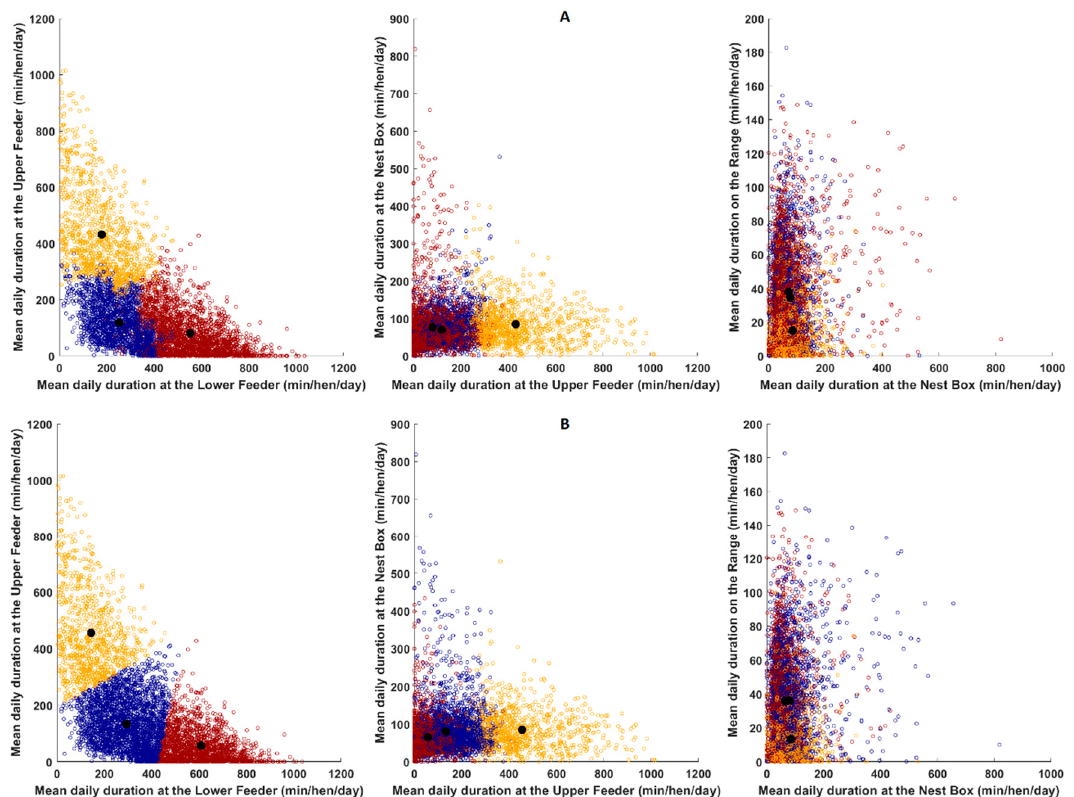
Figure 2. Faceted, 2-dimensional scatter plots of the clustered data across the 4 dimensions that were used to create the clustering solutions using agglomerative clustering ( A ) and K-means clustering ( B ) for the pre-laying period. Each circle represents an individual hen. The black dots represent the respective cluster centroids, plotted in the dimensions displayed for each scatter plot. Cluster membership is denoted by the marker color (cluster 1 = orange, cluster 2 = dark blue, and cluster 3 = dark red). Note the cluster distribution is different for each method.